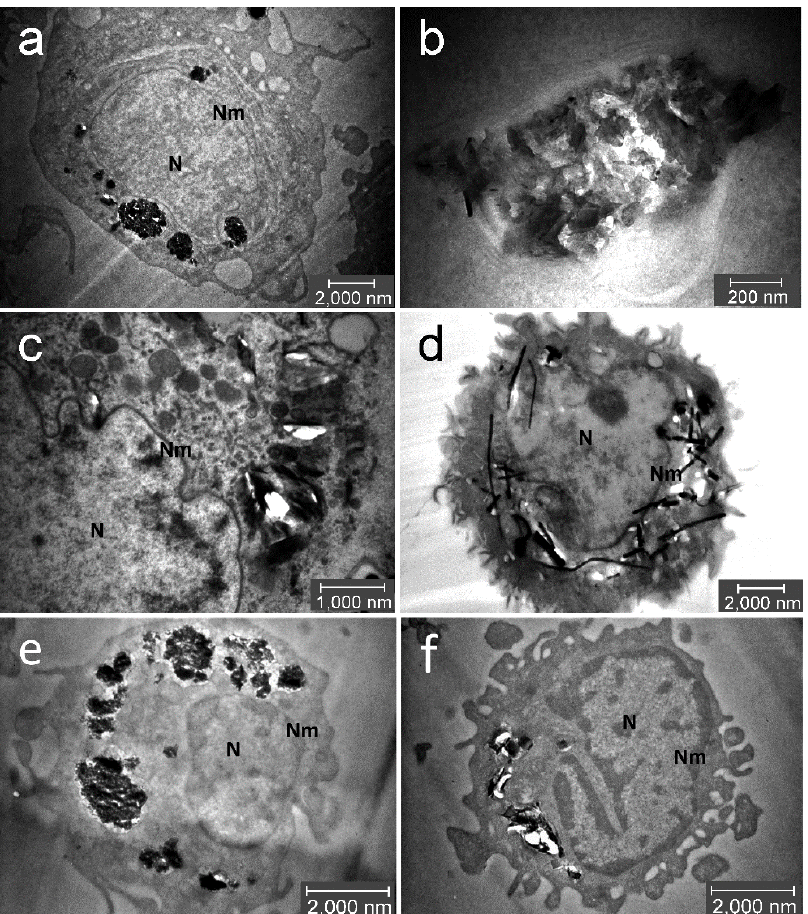
Figure 4. Intracellular localisation of C-BNM after 24 h exposure in THP-1 ( a – d ) and primary monocytes ( e , f ): GP1 ( a , b , e ) forms large aggregates in cytoplasm apparently in vesicles. No particles are found in nucleus (N); ( c, f ) GP2 forms smaller aggregates in cytoplasm, apparently in vesicles. Occasionally, free particles are detected in cytoplasm; ( d ) MWCNT were found as free needle-like objects in the cytoplasm, possibly from damaged lysosomes. Sporadically, they can be found in nucleus or penetrating through the nuclear membrane (Nm)